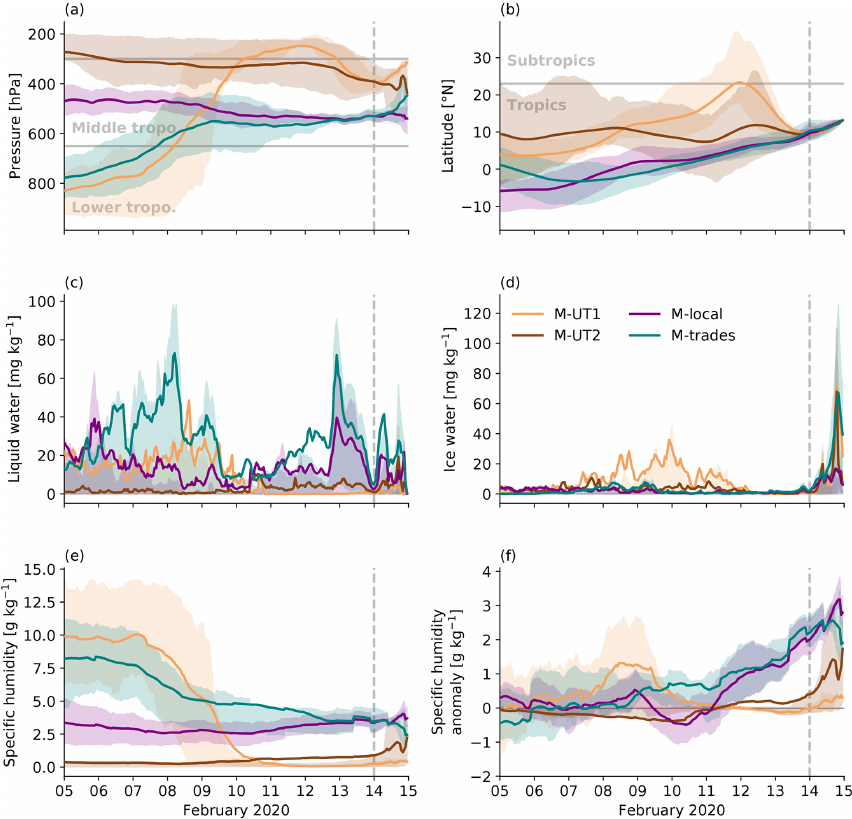
Figure 15. Time series along the four airstreams arriving at the BCO in the layer 650–300hPa on 14 February 2020. The variables shown are (a) pressure, (b) latitude, (c) liquid water content, (d) ice water content, (e) specific humidity, and (f) anomaly in specific humidity calculated relative to the level-specific campaign mean value at the location of the trajectory. Thick lines show mean values and the shading the 25th–75th percentile range. The number of trajectories assigned to each airstream is given in Table 4. Note that from 00:00UTC on 14 February 2020 (dashed gray line) onward the number of trajectories in the airstreams continuously decreases as they reach the BCO. Data: ERA5. Table 5. The 65 TMD days from the quasi-climatological period. Data: